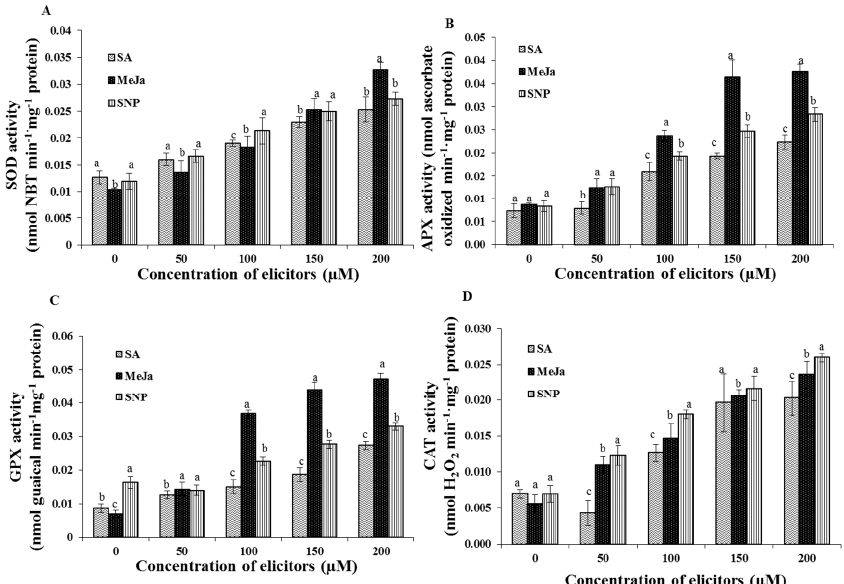
Figure 4. Effect of chemical elicitor treatments on antioxidant enzymes activities of cell suspension cultures. The activity of superoxide dismutase ( A ); ascorbate peroxidase ( B ); guaiacol peroxidase ( C ); and catalase ( D ) estimated in the cell suspension culture. Data are the mean ˘ SE from three replicates. Different letters (a, b, c) in one measurement indicate statistically significant difference at p ď 0.05 by Duncan multiple range